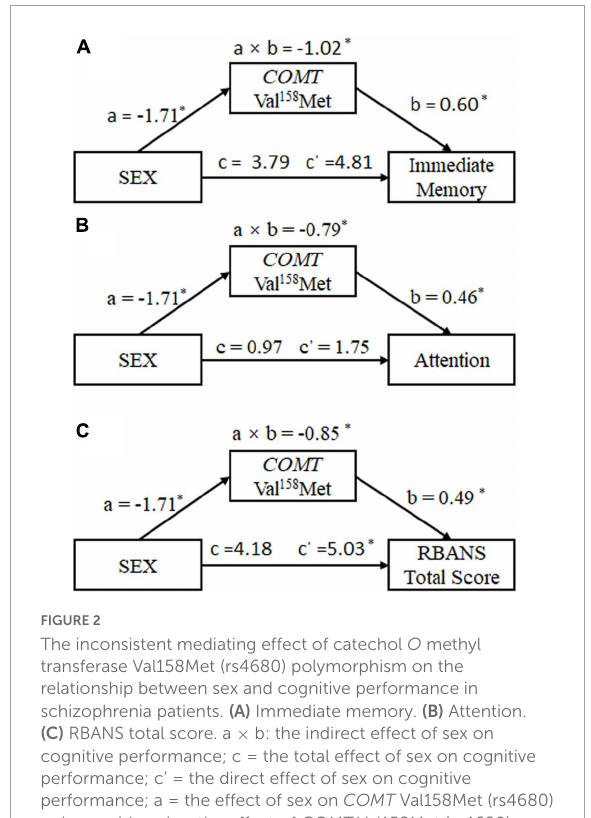
FIGURE2 The inconsistent mediating effect of catechol O methyl transferase Val158Met (rs4680) polymorphism on the relationship between sex and cognitive performance in schizophrenia patients. (A) Immediate memory. (B) Attention. (C) RBANS total score. a × b: the indirect effect of sex on cognitive performance; c = the total effect of sex on cognitive performance; c’ = the direct effect of sex on cognitive performance; a = the effect of sex on COMT Val158Met (rs4680) polymorphism; b = the effect of COMT Val158Met (rs4680) polymorphism on cognitive performance. ∗ p <